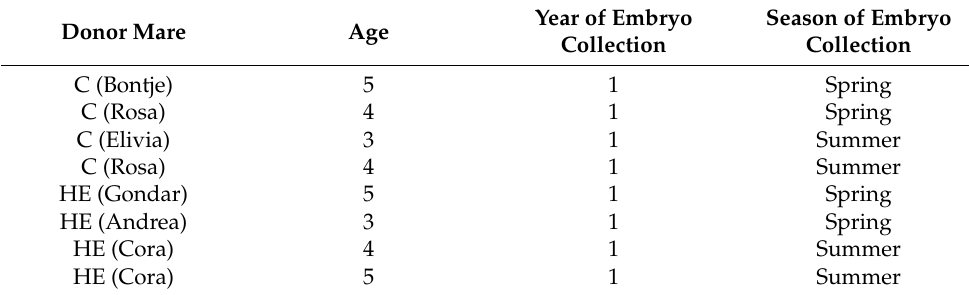
Table 3. Donor mares including their age and the year and season in which embryo collection was